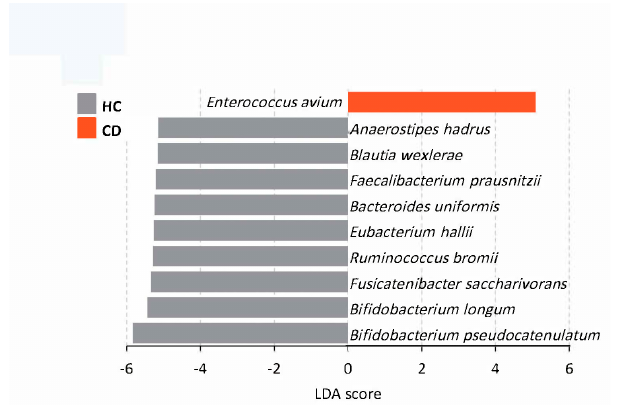
Figure 3. LEfSe identified representative species in healthy controls and CD patients at baseline. Species that fell below FDR < 0.05 and log LDA cutoff ≥ 5.0 were considered significant for feature level comparisons. HC, healthy controls; CD, Crohn’s disease.